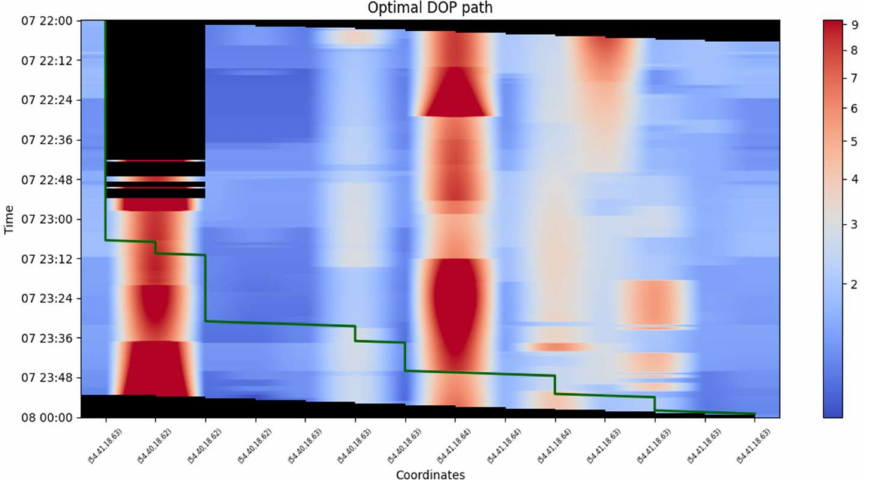
Figure 5. Diagram of the optimal 2D route. The colour of the surface depends on the DOP value. The black areas are locations for which the finite DOP value failed to be determined. The black triangles in the corners are unavailable areas. The green line is an optimal